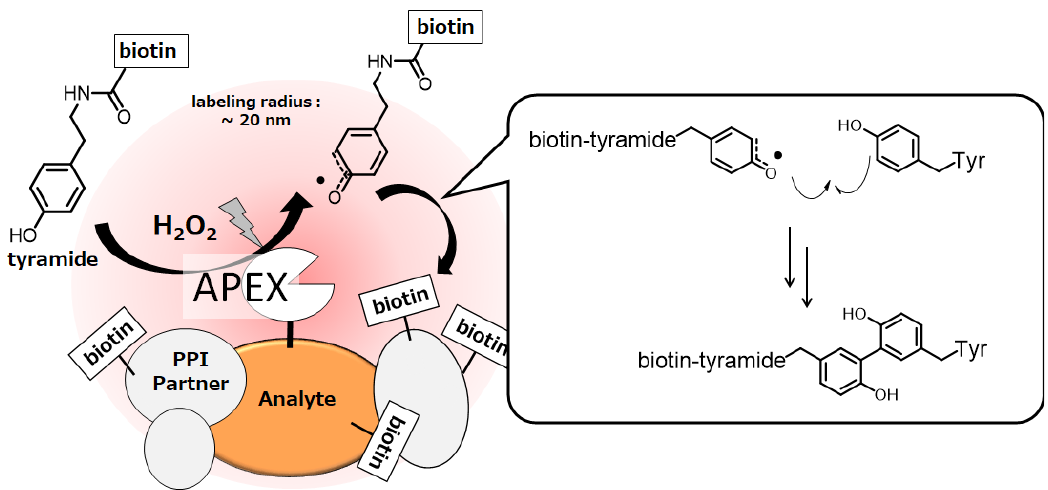
Figure 4. Ascorbate peroxidase (APEX) -proximity labeling of endogenous proteins in living